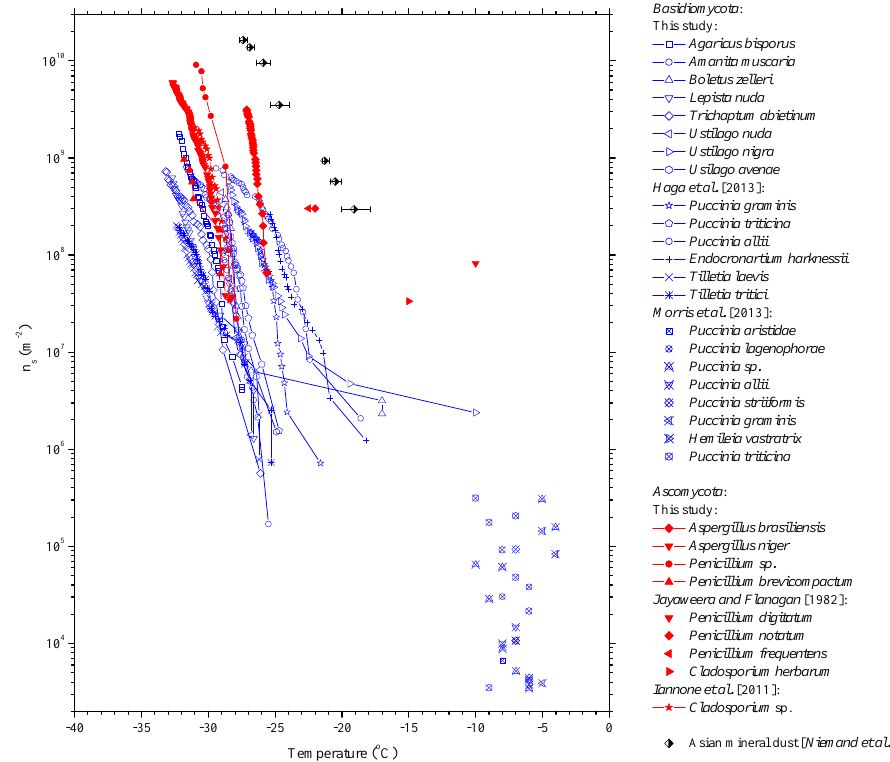
Figure 6. Comparison between ice nucleation active surface site density spectra ( n s vs. T ) for Ascomycota and Basidiomycota fungal spores calculated using the data in Fig. 5 and using approximations for spore size and shape detailed in the text. Included are results from the current study as well as results from the following studies: Haga et al. (2013), Iannone et al. (2011), Jayaweera and Flanagan (1982), and Morris et al. (2013b). Also shown in the figure are previous results for submicron Asian mineral dust (Niemand et al., 2012).